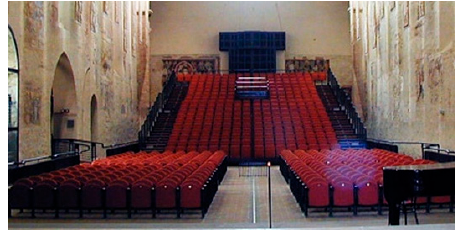
Figure 7. Sitting area in S. Dominic of Foligno.